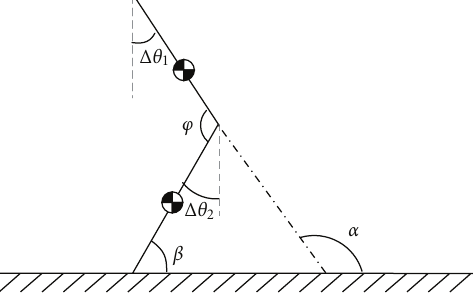
Figure 10: Lower limb joints